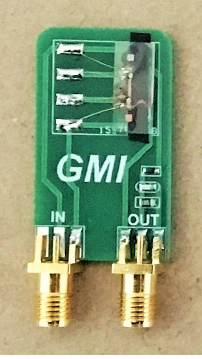
Figure 7. The test module of the amorphous wire alloy magnetic sensor impedance. The diode detector circuit consists of a capacitor, a resistor and a diode.